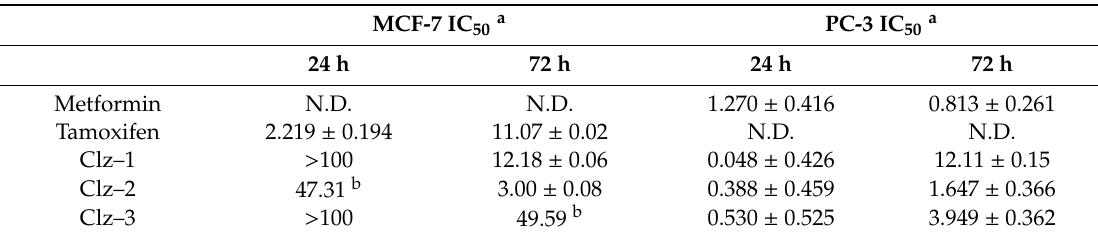
Table 1. Cytotoxicity of the drugs Metformin and Tamoxifen, as well as Clz–1, Clz–2, and Clz–3, in PC-3 and MCF-7 tumor cell lines (24 and 72 h treatment). IC 50 ( µ M) values are given as mean of 6 experiments.